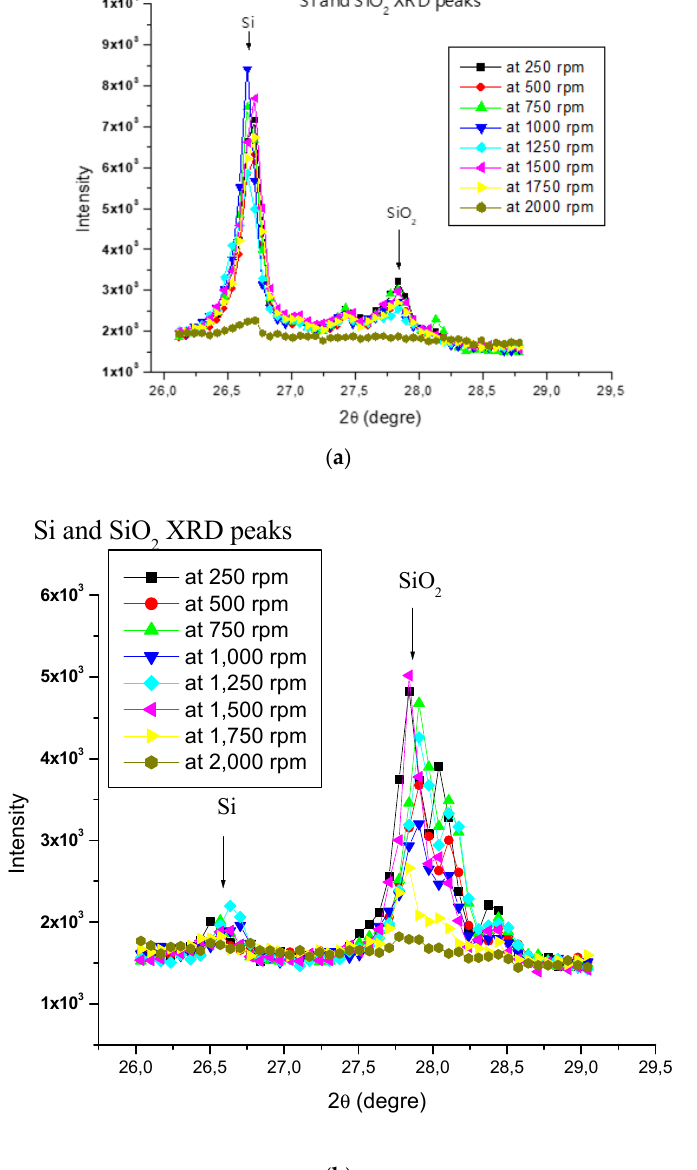
Figure 3. XRD patterns obtained at different polishing rotation speeds for ( a ) white granite, and ( b ) Black granite (Canadian anorthosite), using 508 mm/min feed rate, 0.2 bar pressure, and 60 grit